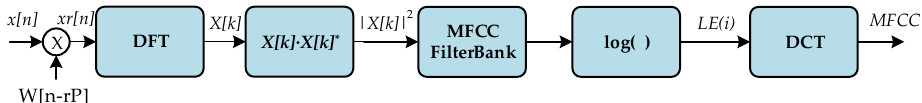
Figure 5. Bloc diagram of the Mel Frequency Cepstral Coefficients (MFCC) extraction procedure from the input acoustic signal x ( n ) , where W [ n − rP ] is the Hamming windowing, X [ k ] is the discrete Fourier transform of the framed input signal, LE ( i ) is the logarithm of the filter bank coefficients and MFCC the output